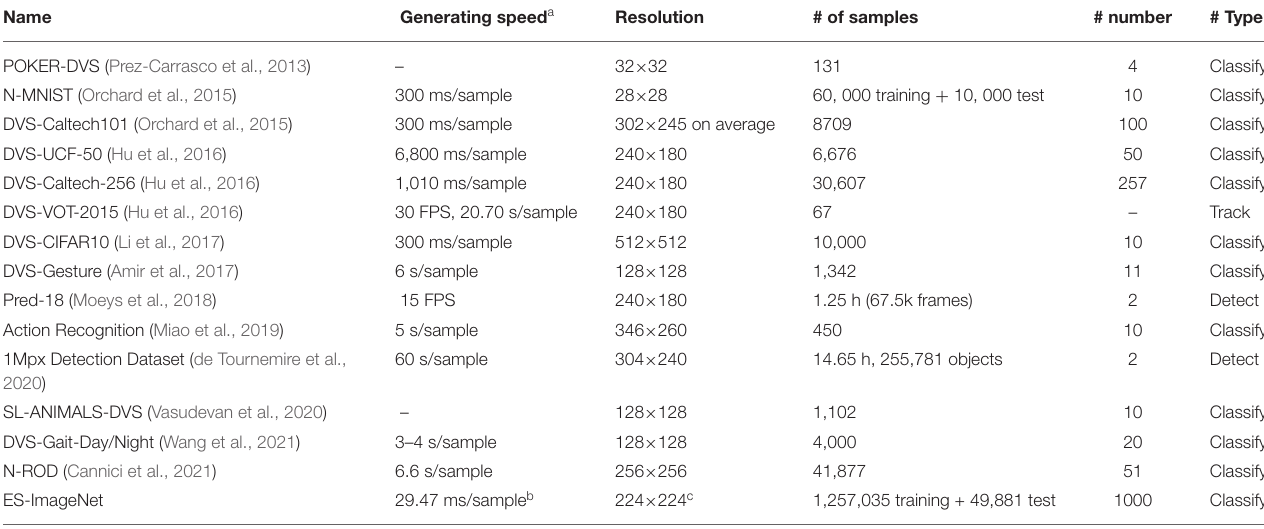
TABLE 1 | Comparison between existing ES-datasets and